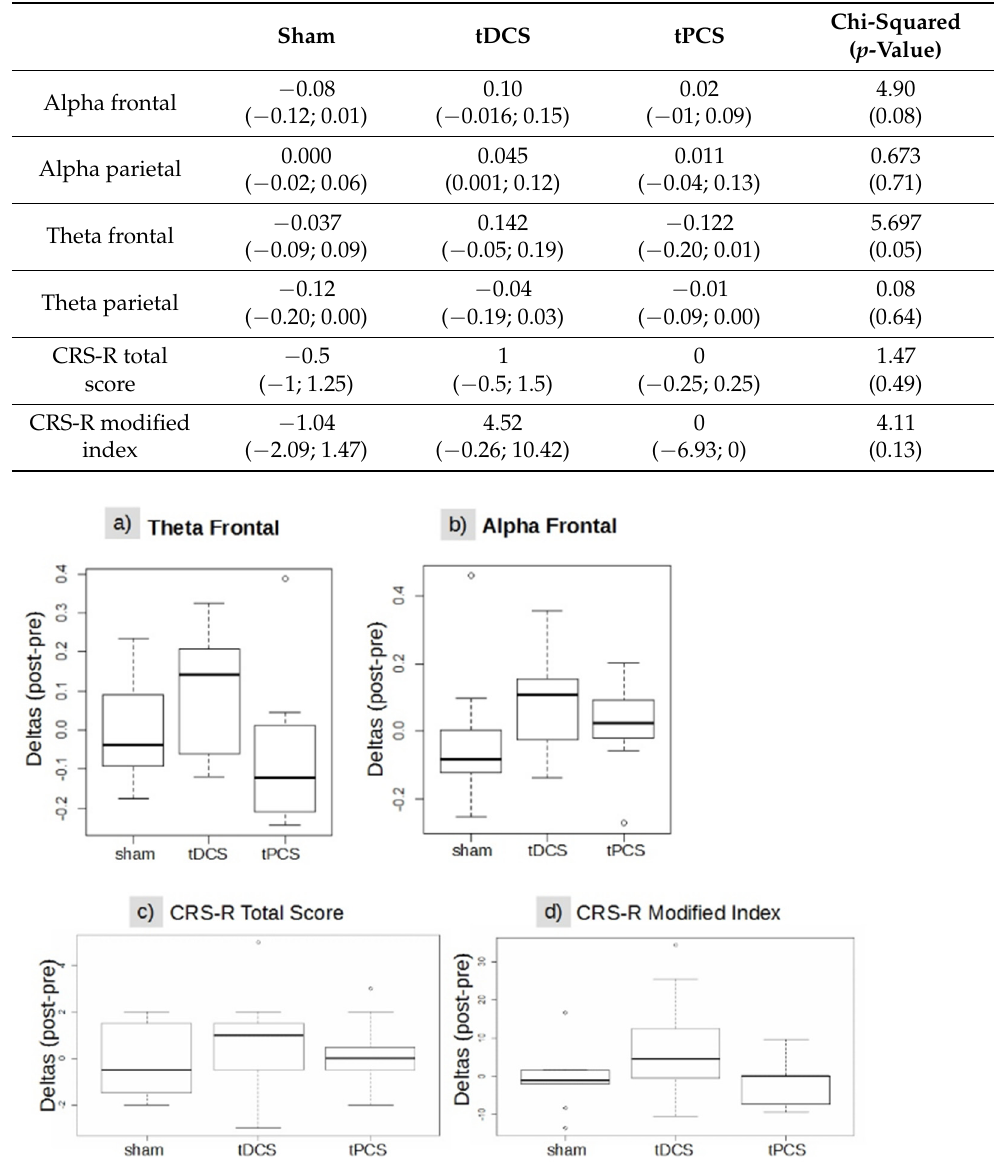
Figure 3. ( a – d ) Boxplot group differences between treatment conditions. ( a ) Functional connectivity in the frontal theta band, ( b ) in the frontal alpha band, ( c ) CRS-R total score, and ( d ) CRS-R modified index. The rectangles represent the interquartile range 25 and 75; the bold horizontal lines inside the rectangles are the medians of each group, empty circles indicate potential outliers (minimum or maximum value in the data) whereas the whiskers are calculated by the default boxplot R function and represent 1.5 distance from IQR 25 and IQR 75. CRS-R = Coma Recovery Scale-Revised, Sham = sham treatment, tDCS = transcranial direct current stimulation treatment, tPCS = transcranial pulsed current stimulation treatment, IQR = interquartile range.